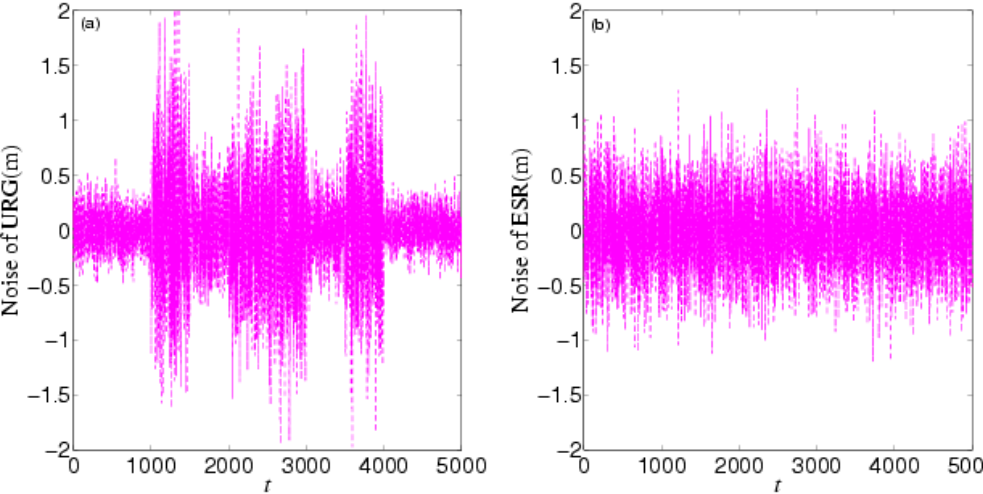
Figure 8. The noise of ( a ) URG and ( b ) ESR in the first experiment.